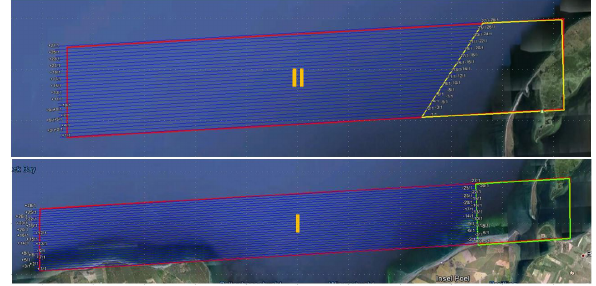
Figure 5: Lowest altitude (300m) for Area 1 and 2 is not possible in highlighted parts because of migrating birds.